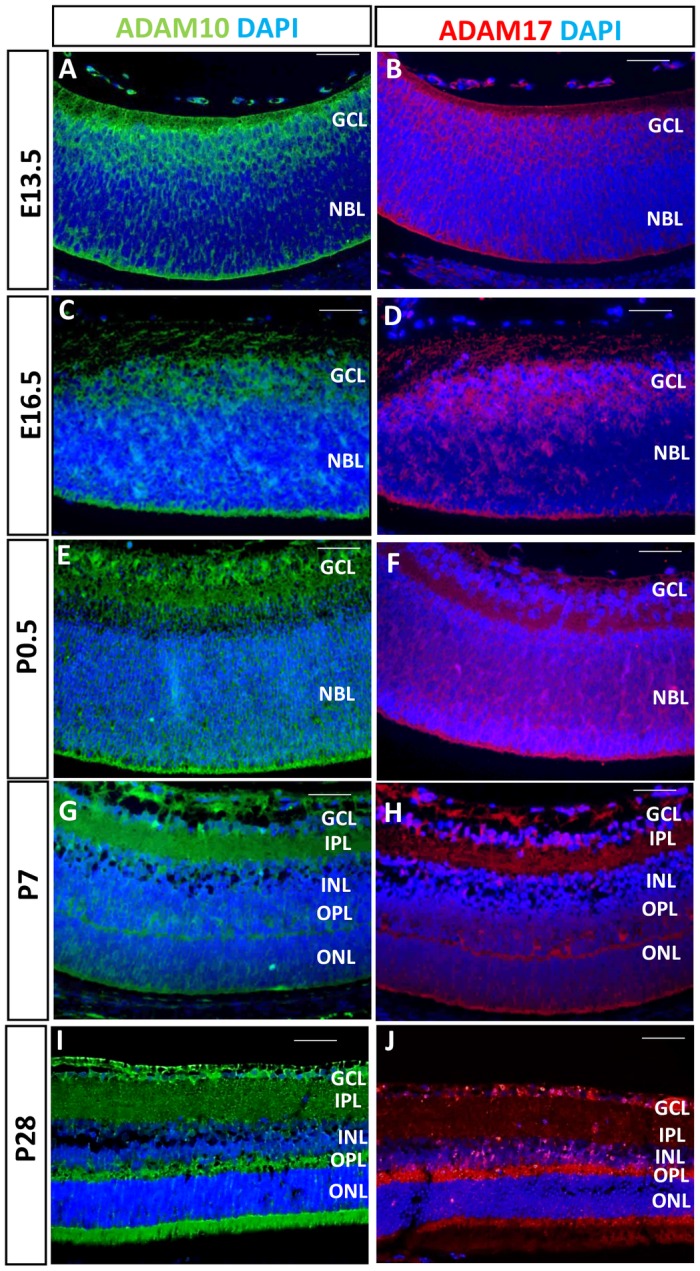
Expression of ADAM10 and ADAM17 in the retina.Immunostaining of control E13.5 retinae for ADAM10 (A) and ADAM17 (B), E16.5 retinae for ADAM10 (C) and ADAM17 (D) and P0.5 retinae for ADAM10 (E) and ADAM17 (F) revealed similar expression patterns in the ganglion cell layer (GCL) and neuroblastic layer (NBL). Immunostaining of P7 retinae for ADAM10 (G) and ADAM17 (H) and P28 retinae for ADAM10 (I) and ADAM17 (J) also revealed similar expression patterns in the inner plexiform layer (IPL), outer plexiform layer (OPL) and in the photoreceptors. INL = inner nuclear layer; ONL = outer nuclear layer. Nuclei were stained with DAPI. Scale bars = 50 μm.